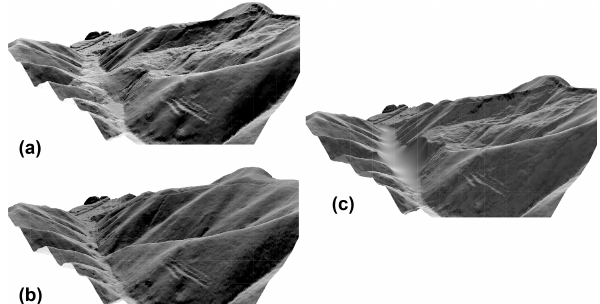
Figure 8. ArcScene illustration of the difference between the post- DEM (a) , pre–DEM (b) , and the SLBL reconstruction (c) of the valley filled by the Kitamata landslide.